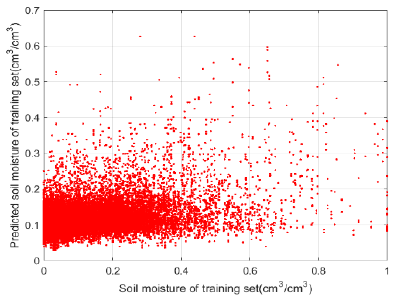
Figure 8. SVM classification with a training dataset